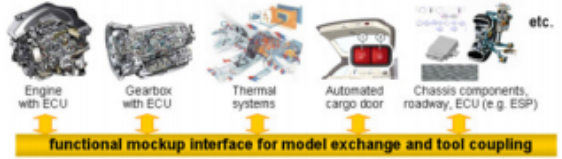
Figure 3. FMI integration